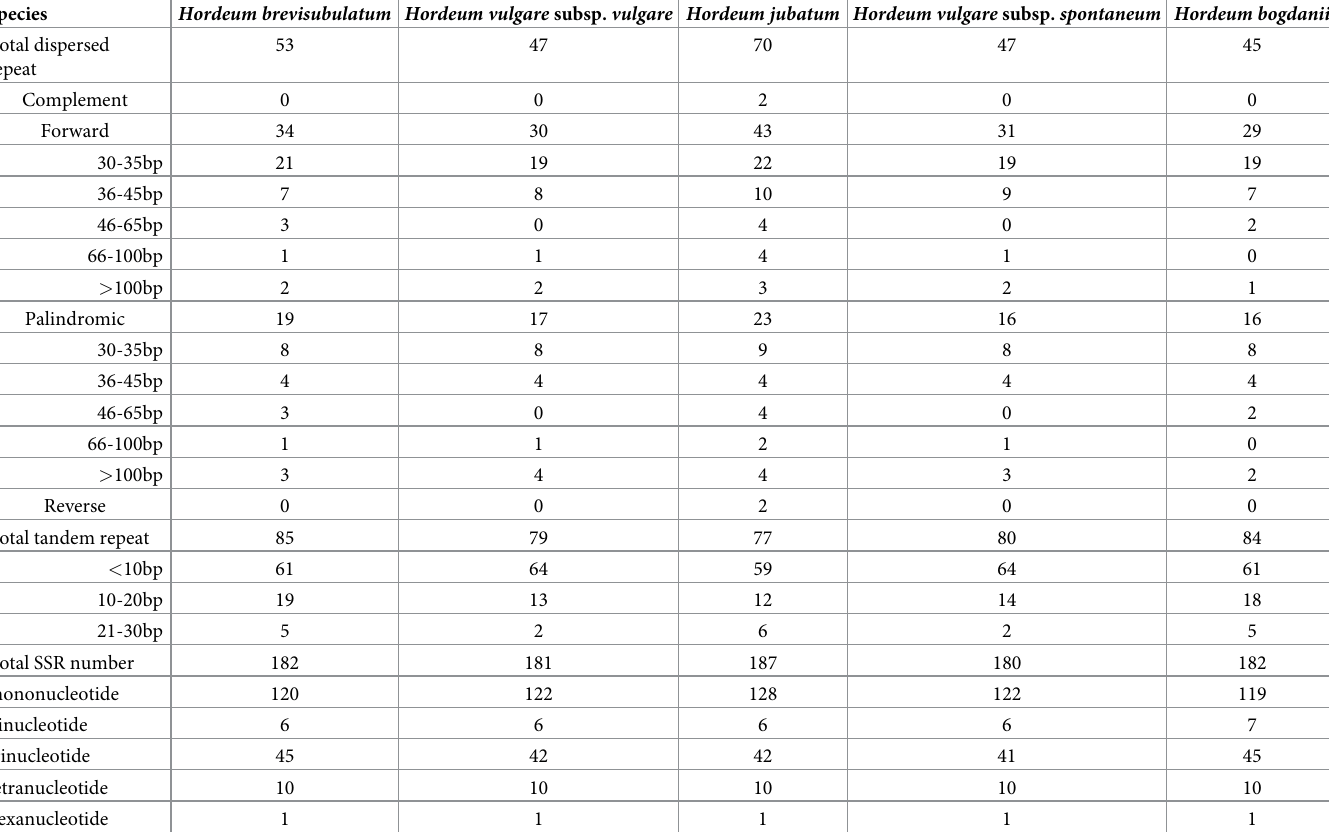
Table 2. Summary of repeat sequences and SSRs in five Hordeum chloroplast genomes.